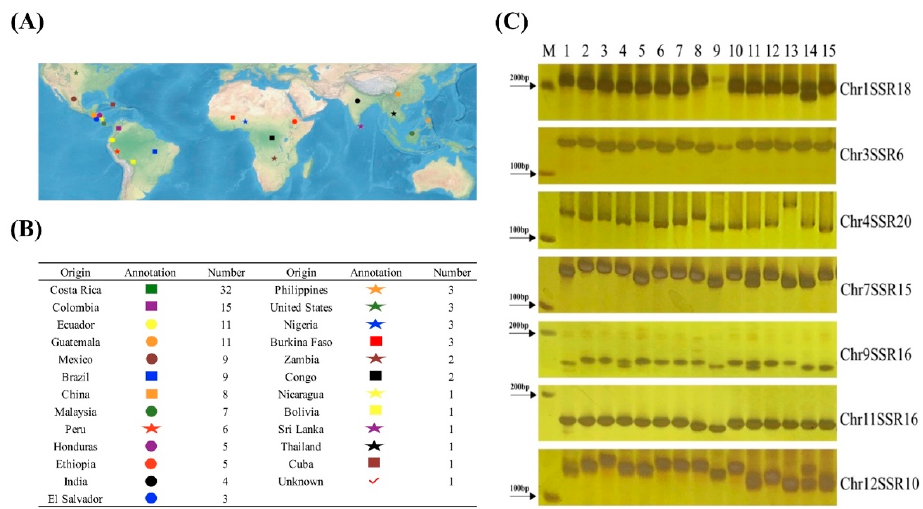
Figure 2. Regional distribution of the 147 pepper ( C. frutescens ) cultivars, and the detailed information material collected from these countries. ( A ) Regional distribution of the 147 pepper cultivars in this study, mainly collected from Central and South America, Africa, and Asia; ( B ) Labeling of 25 countries on the map, and information material collected from these countries (including an unidentified source); ( C ) Polyacrylamide gel electrophoresis analysis of 7 SSR markers with high polymorphism on samples 1 to 15. Table 2. Polymorphism analysis of the 147 C. frutescens accessions with SSR primers. Primer Allele Size